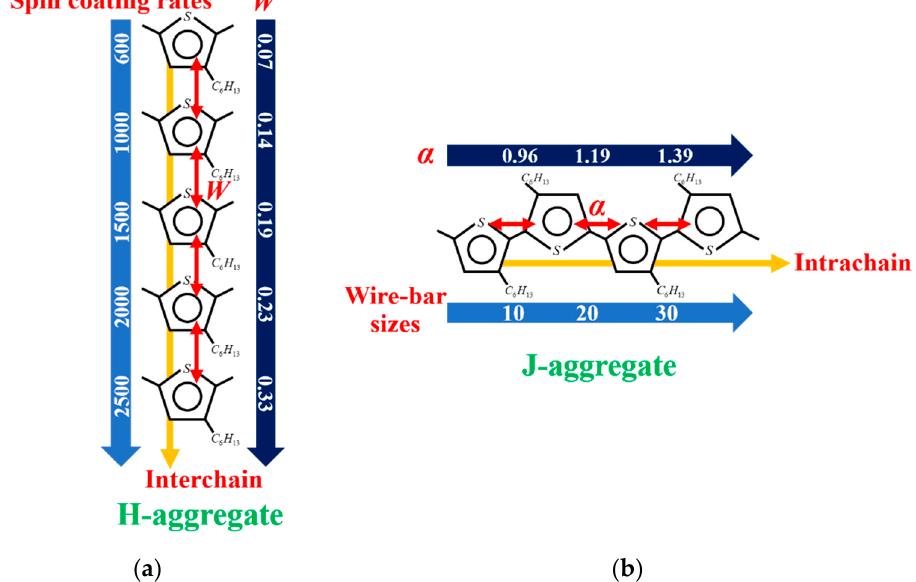
Figure 5. The schematic diagram of the relationship between processing methods, molecule aggregation, and the electronic spatial coherence of poly (3-hexylthiophene-2,5-diyl) (P3HT) film in H- ( a ) and J-aggregate ( b ) regimes, where W is free-exciton bandwidth and α is coherence number.